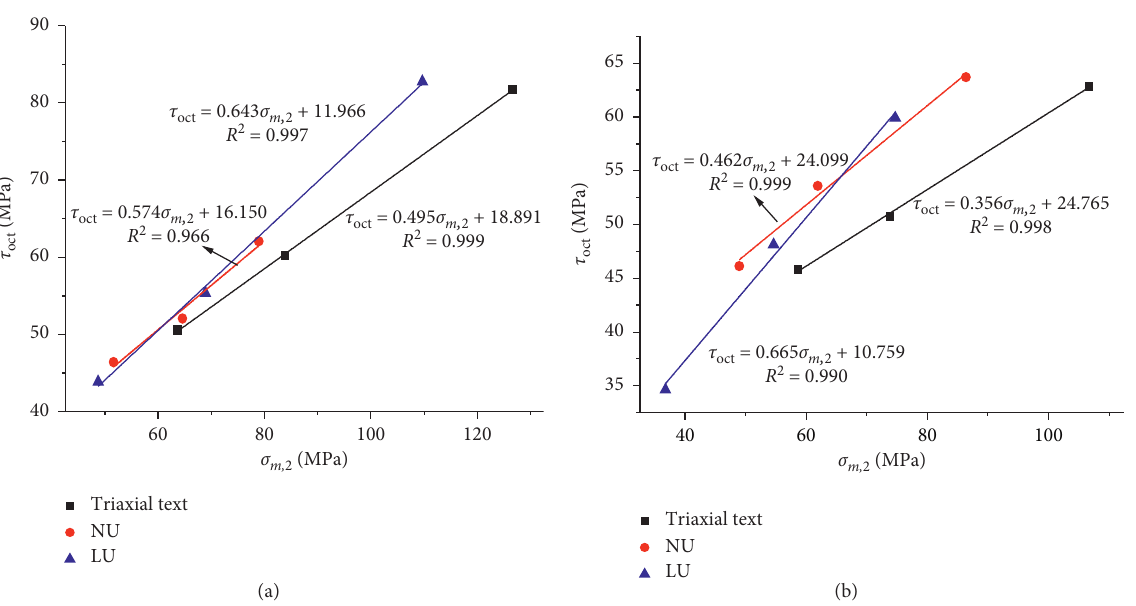
Figure 16: Mogi–Coulomb criterion: (a) V